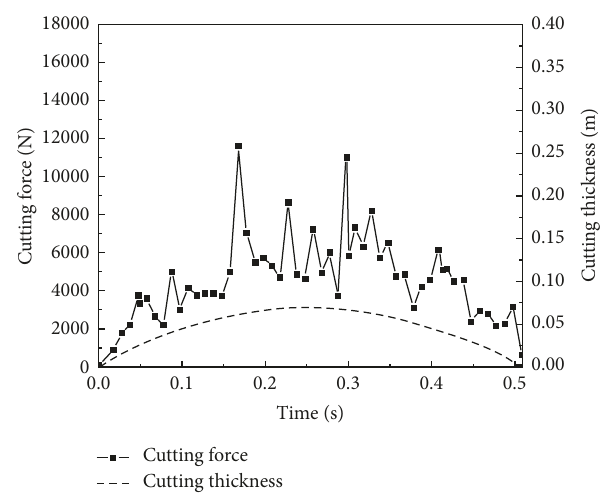
Figure 6: Cutting force of conical pick under the cutting parameter B .